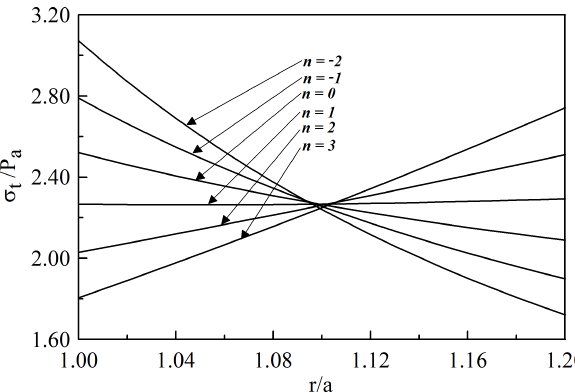
Figure 18: Radially distributed radial stress